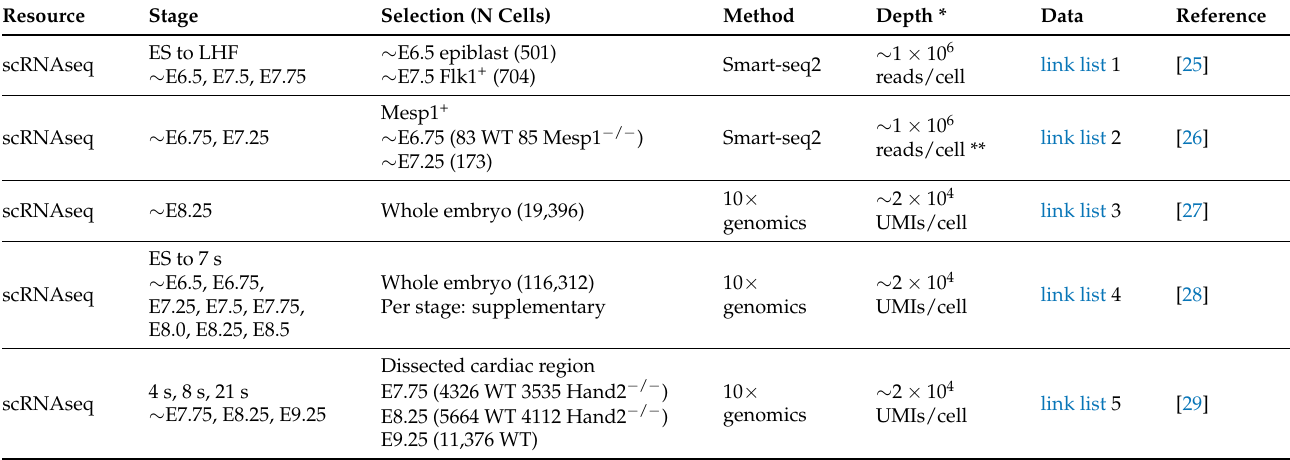
Table 2. Single-cell sequencing and live imaging data from mouse embryos available in the literature. Links to the raw and processed data and their website interfaces are provided when available